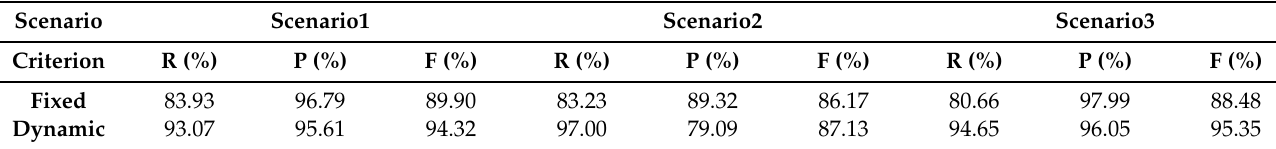
Table 2. Effect evaluation of dynamic step